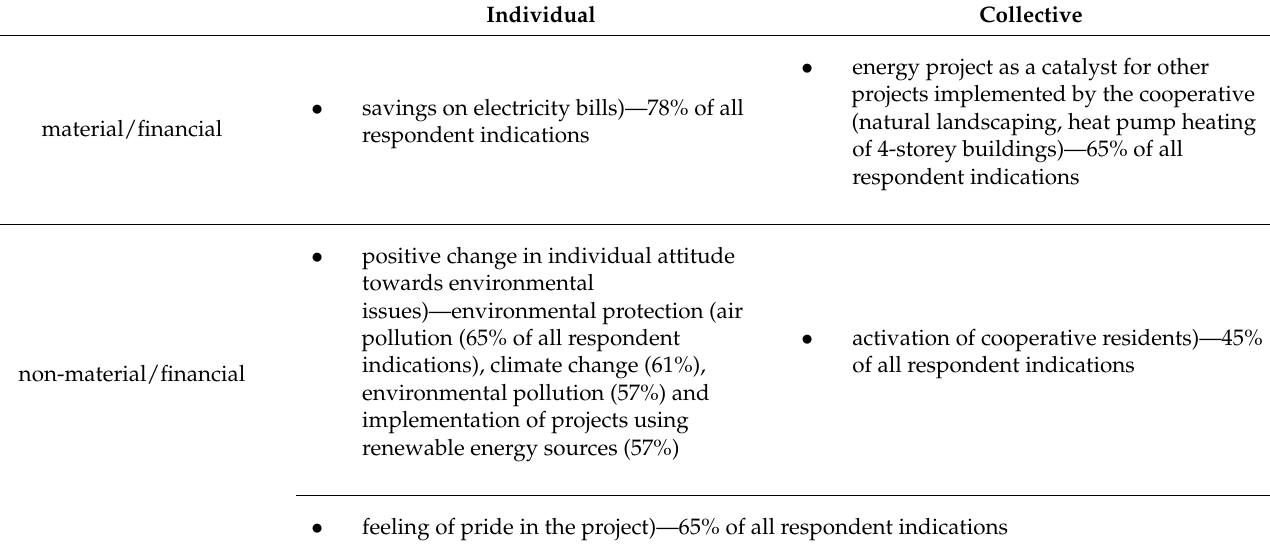
Table 7. Respondents’ motivation matrix—material/intangible and individual/collective